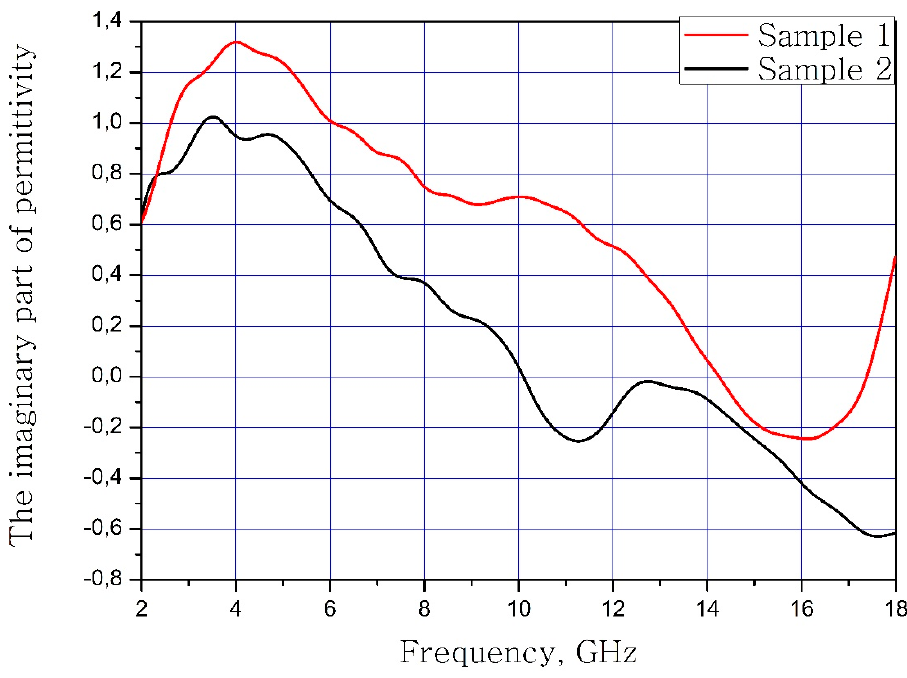
Figure 4. Frequency dependence of the imaginary part of the dielectric permittivity of the samples. The results of calculations of the dependence of the real and imaginary parts for magnetic permeability on the frequency of the material samples are present in Figures 5 and 6.